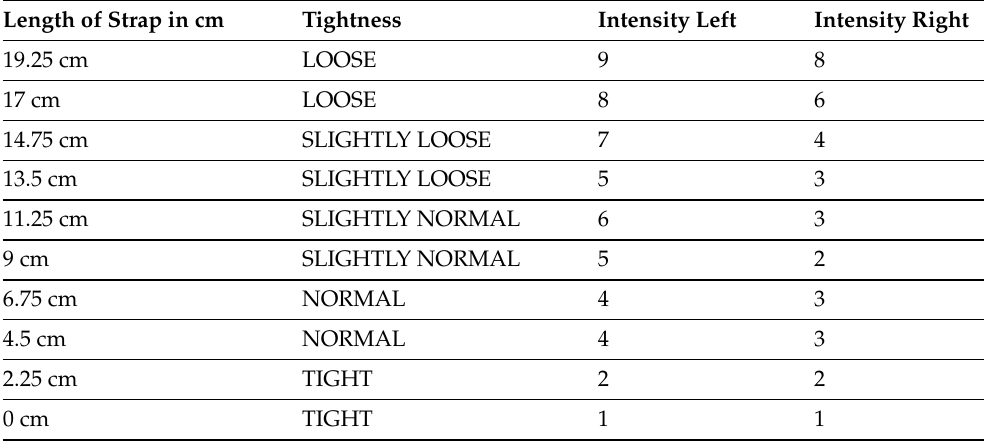
Table 2. Readings of the experiment of light intensity sensors with surgical